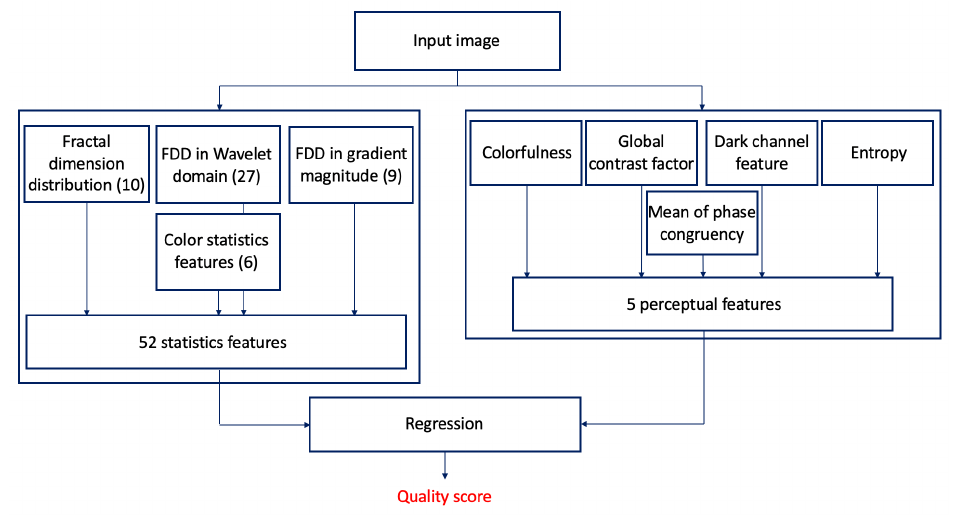
Figure 1. Architecture of the proposed no-reference image quality assessment